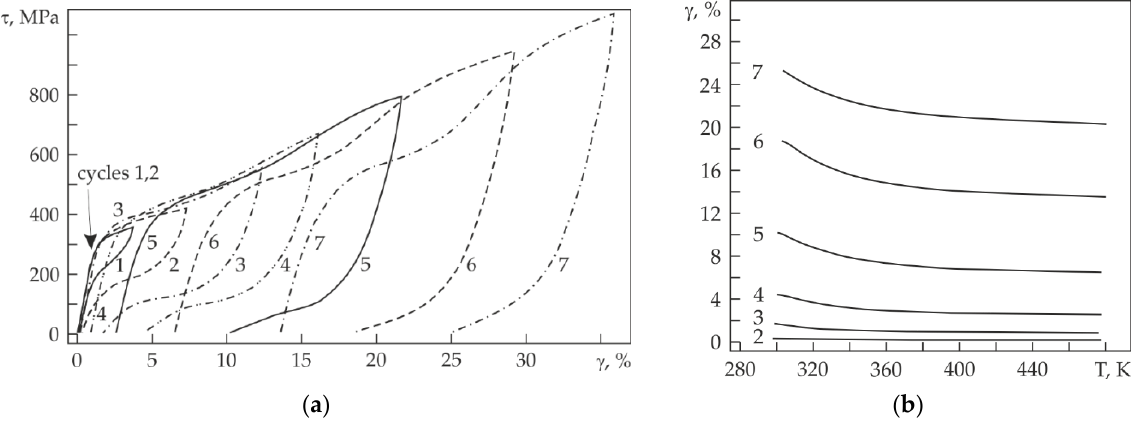
Figure 4. Accumulation and recovery of inelastic strain in loading–unloading cycles at 299 K ( a ) and its recovery on further heating ( b ).